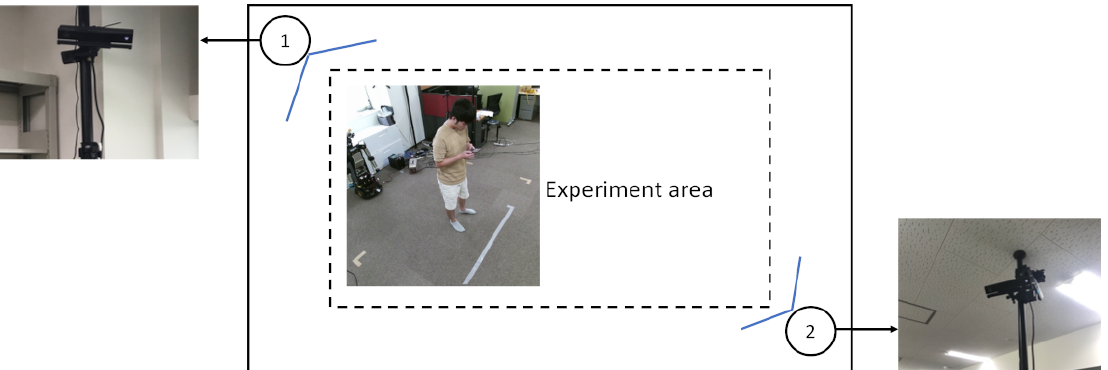
Figure 1. An illustration of the experimental setup. The circles represent the positions of the Kinect sensors. The size of the experiment area is about 2.8 × 1.5